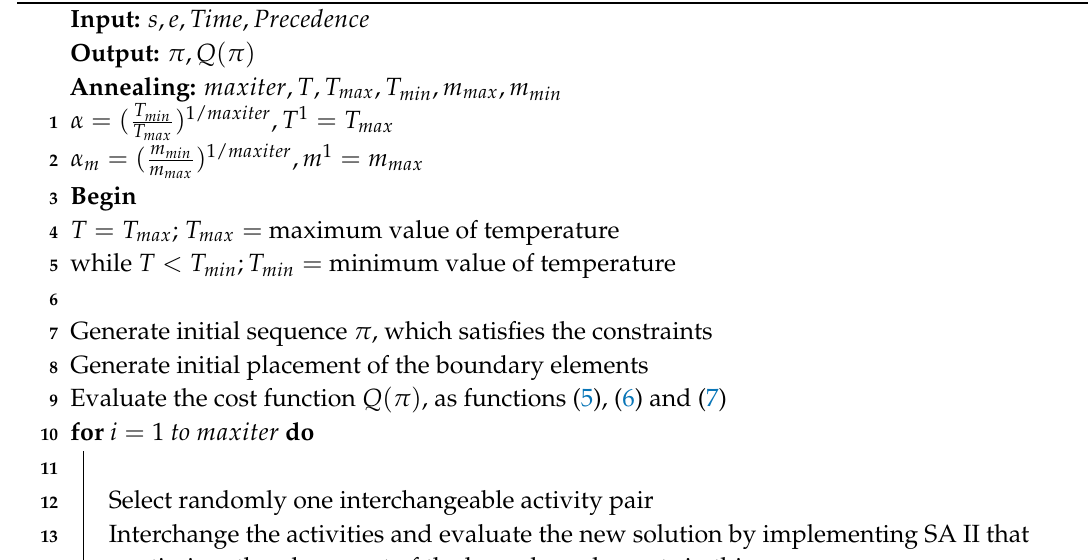
Algorithm 1: Pseudocode of the proposed SA-ALB